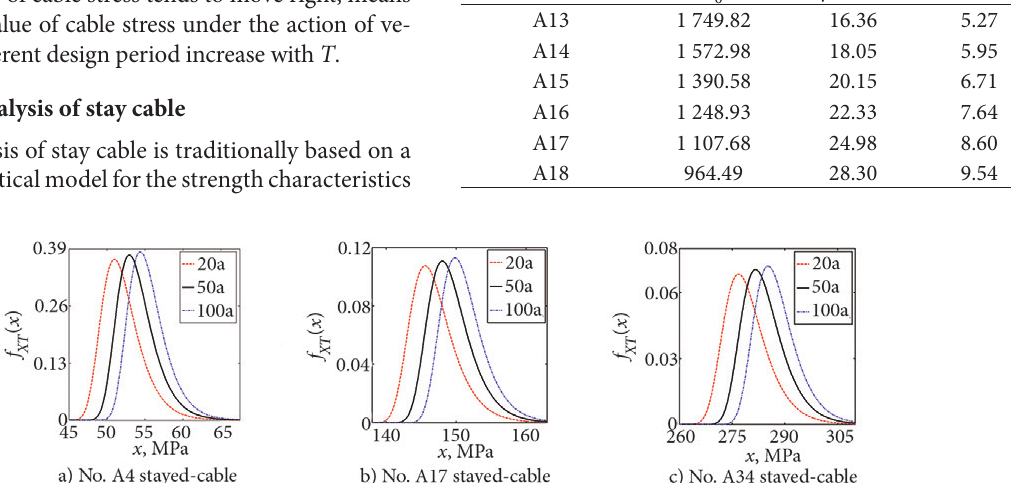
Fig. 10. Up-crossing rates and fitting curves for A17 and A34 cable stress under random vehicle loads Table 6. Fitting parameters of up-crossing rates for cable stress Cable No.